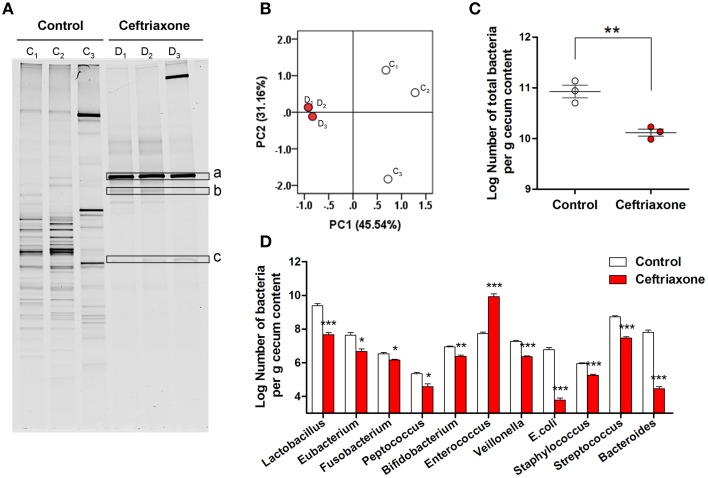
Ceftriaxone induced intestinal dysbiosis in mice. (A) DGGE pattern of the cecal microbial community of mice. C1–C3, control mice, D1–D3, dysbiosis mice. a–c, the bands differ from control were extracted from the DGGE gel and sequenced. (B) PCA of the DGGE profile. Community similarity was calculated using the weighted UniFrac distance metric, which incorporates phylogenetic as well as relative abundance information. PC1 and PC2 account for 76.70% of the variation. White dots, healthy mice; red dots, ceftriaxone-treated mice. (C) The total population of intestinal microbes in control and ceftriaxone-treated mice detected by qPCR. (D) The population of selected commensal bacteria in control and ceftriaxone-treated mice detected by qPCR. *p < 0.05; **p < 0.01; ***p < 0.001.